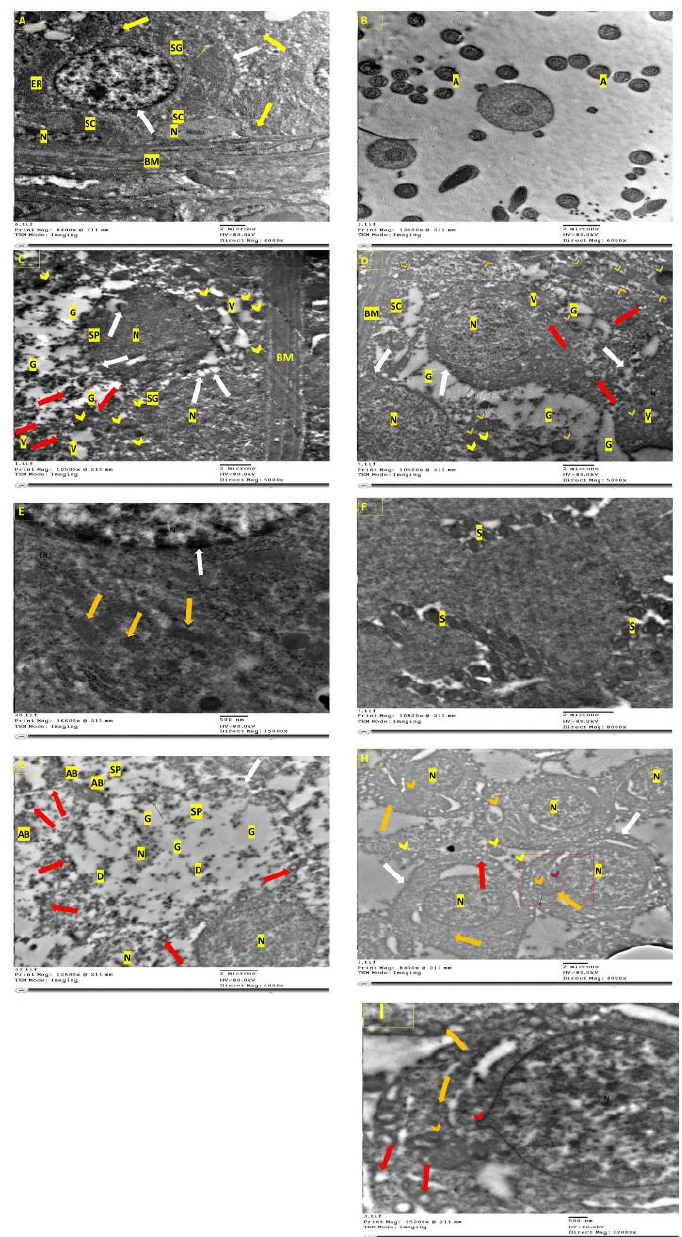
Figure 5. Ultra-structure of testes by Transmission Electron Microscopy. ( A ): Control group with basement membrane, which has myoid cells, and resting in which are spermatogonium with a dome-shaped nucleus, nucleolus, ER, golgi, and large number of mitochondria with intact cristae (yellow arrow). Sertoli cell (SC) exhibited elongated nucleus, nucleolus. Intact nuclear and cytoplas- mic membrane (white arrow). ( B ): Negative control after 2 weeks showing spermatozoa with nor- mal head and containing a nucleus and axoneme (A) with a typical “9 + 2” microtubule structure (nine pairs of peripheral and two central microtubules). ( C ): M/2 w group with irregular basal (BM)